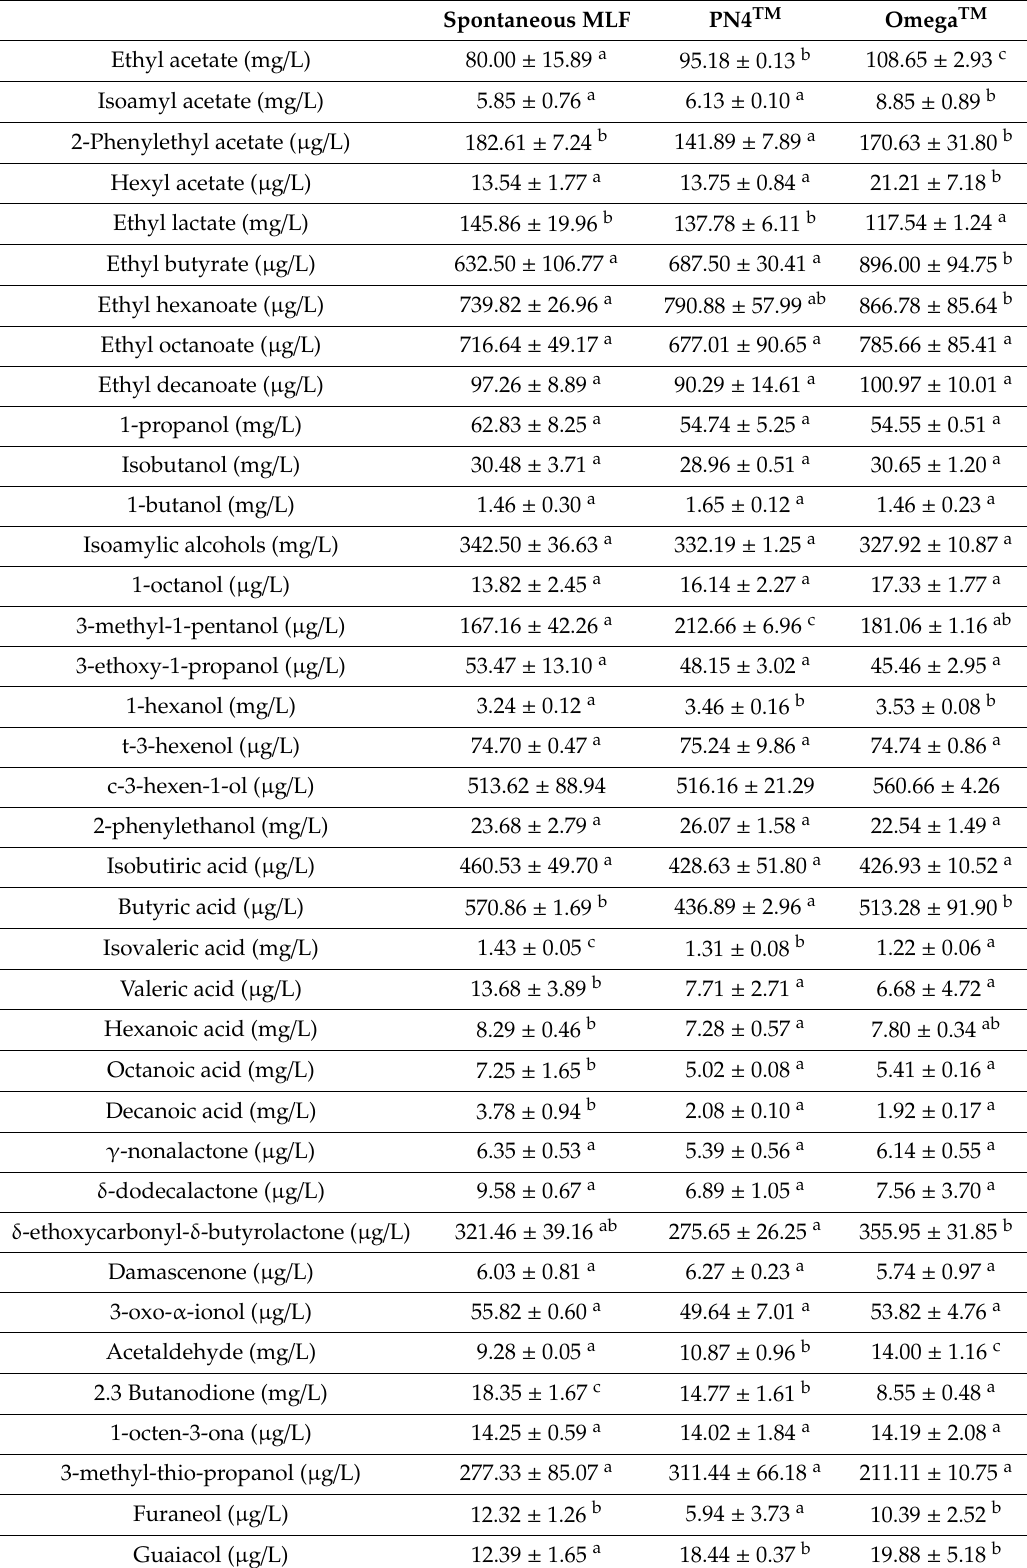
Table 2. Data (Mean ± S.D.) of volatile composition related to the uninoculated fermentations (S) and inoculated fermentations with two commercial LAB strains (PN4 TM and Omega TM ). Characters a, b, and c mean significant di ff erences at p ≤